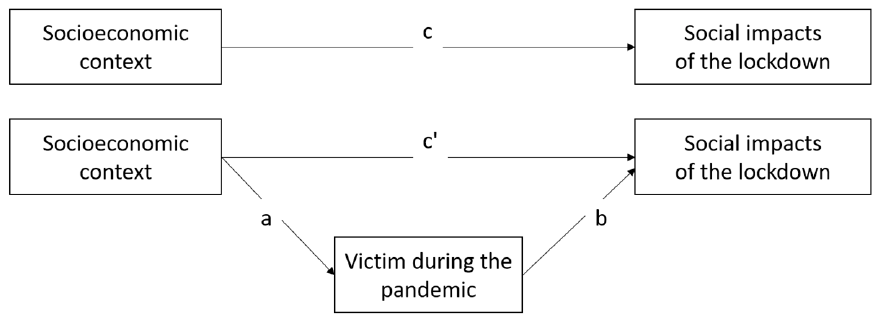
Figure 1. Proposed mediation model for predicting the social impacts of the pandemic in women’s lives. This model allows us to: (1) identify the effect of socioeconomic contexts on victim-